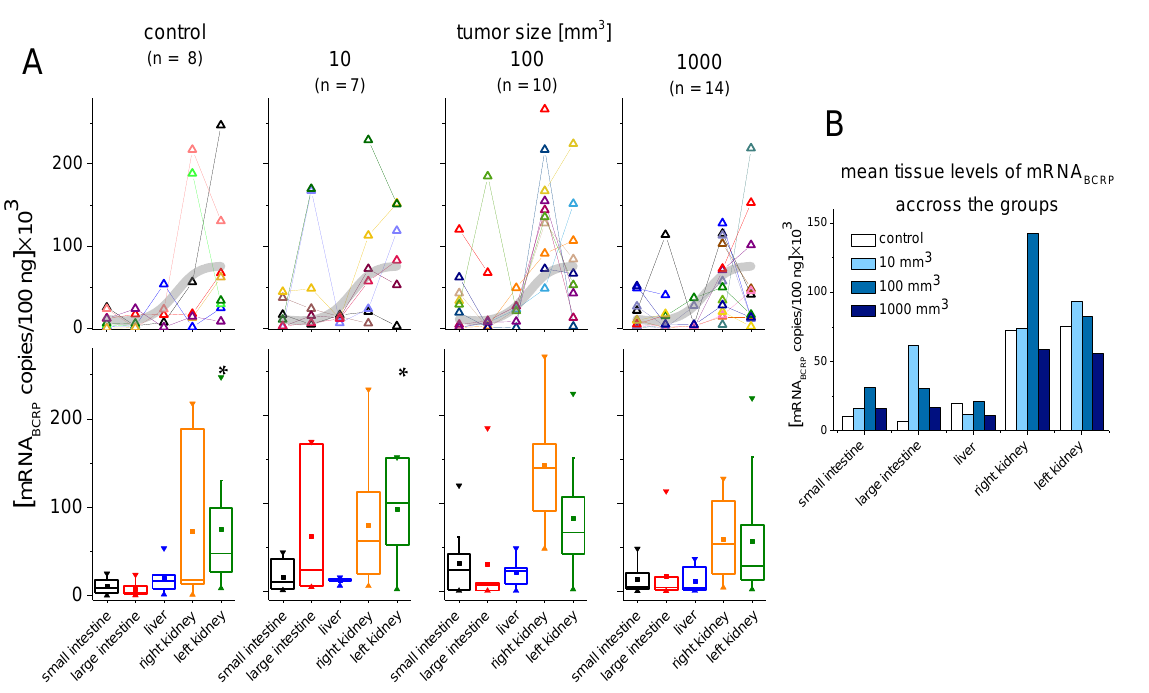
Figure 2. Expression of BCRP in normal tissues of the healthy (control) and tumor-bearing mice, analyzed via a quantitative real-time PCR: the total number of BCRP-coding mRNA (mRNA BCRP ) copies were estimated on the basis of a standard curve (Figure S1, Supplementary Materials), and a statistical analysis of the results was performed using the Origin Pro software. ( A ) The numbers of mRNA BCRP copies (mean values of three replicate tests) in various organs of individual animals. The data points corresponding to a single individual are marked with the same color and connected by straight lines (note that some data points are missing). For a better comparison, the mean level of mRNA BCRP in the control group is shown (thick grey line) in each chart. The group sizes ( n ) are indicated in parentheses. Statistical analysis of the data is shown in the upper panel. The levels of BCRP are shown as the medians (horizontal lines inside the boxes), the 25th to 75th percentile (boxes), the standard errors (whiskers), and the means (squares inside the boxes). * Statistically significant result, p < 0.05; ( B ) The mean levels of mRNA BCRP in normal organs of mice in all the experimental